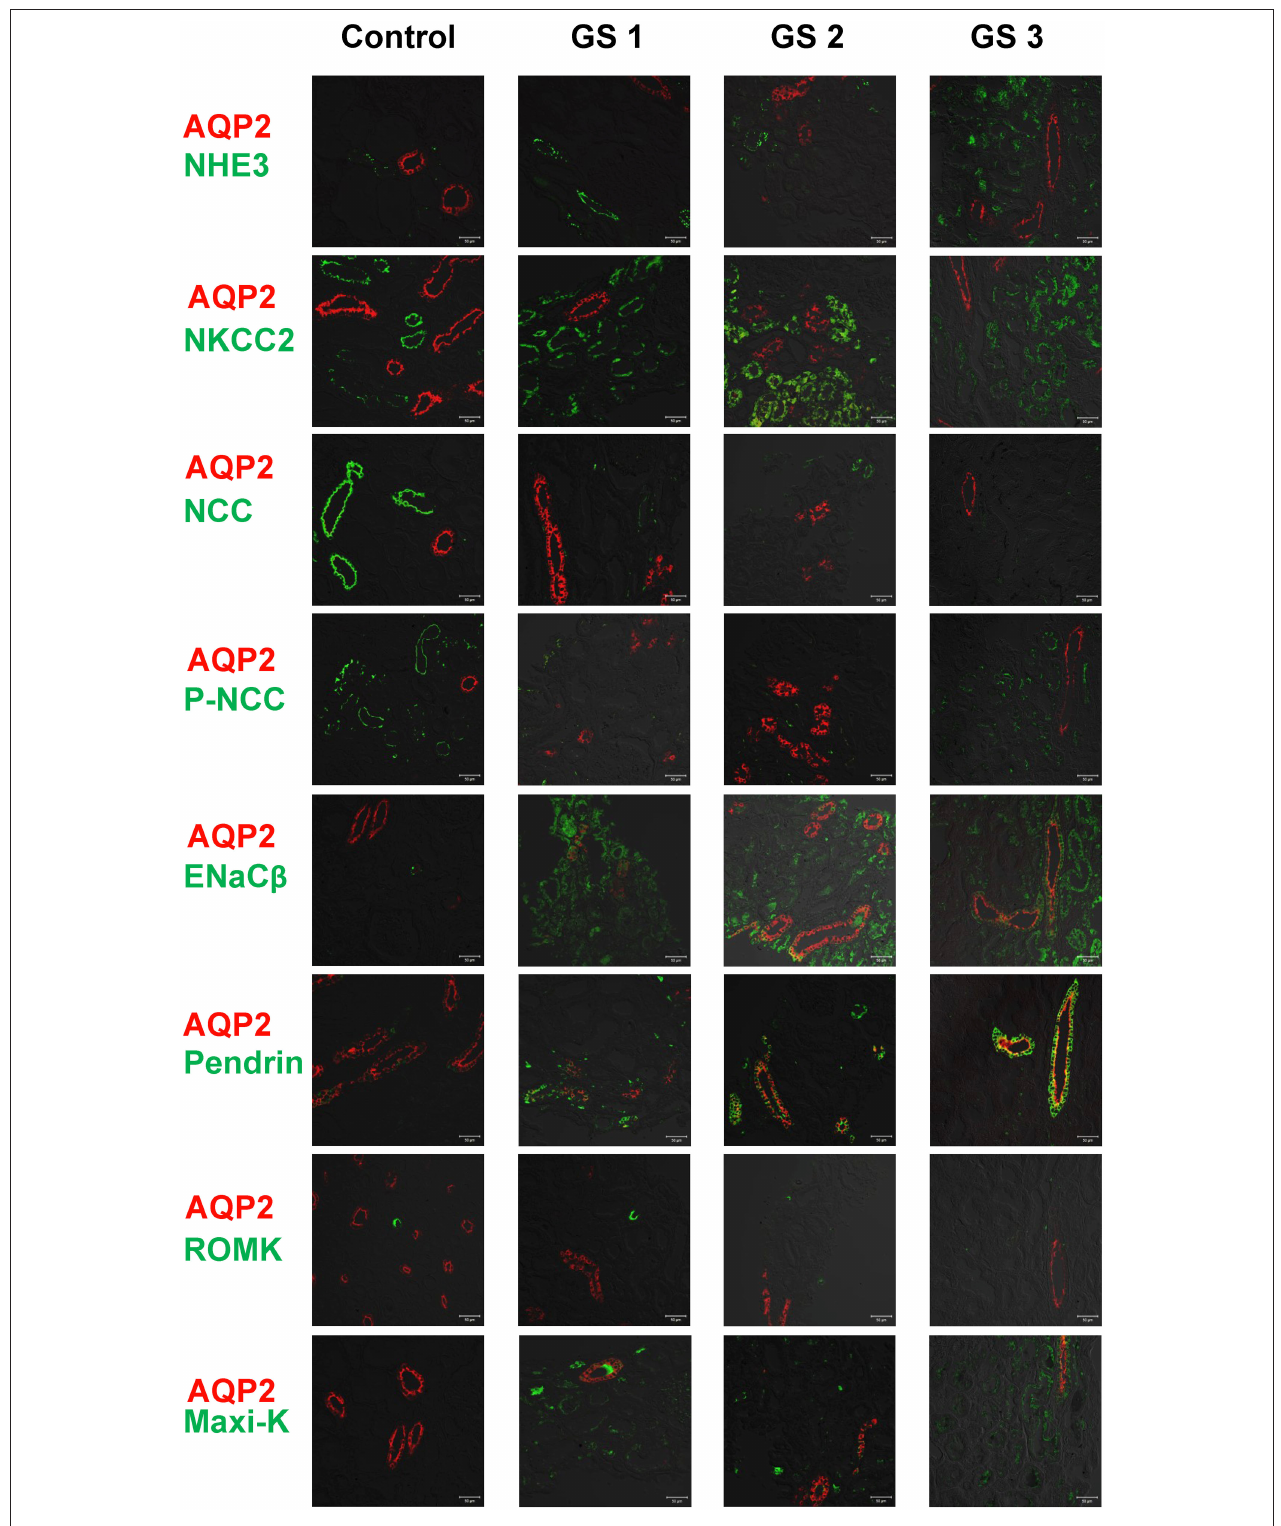
FIGURE 3 | Immunofluorescence of biopsied kidney tissues from another 3 representative GS patients (GS 1, GS 2, and GS 3) compared with the control kidney tissue. Renal transporters including NHE3, NKCC2, NCC, p-NCC, ENaC β , pendrin, ROMK, Maxi-K were stained with green. AQP2 was stained with red for localization. Scale bar, 50 µ